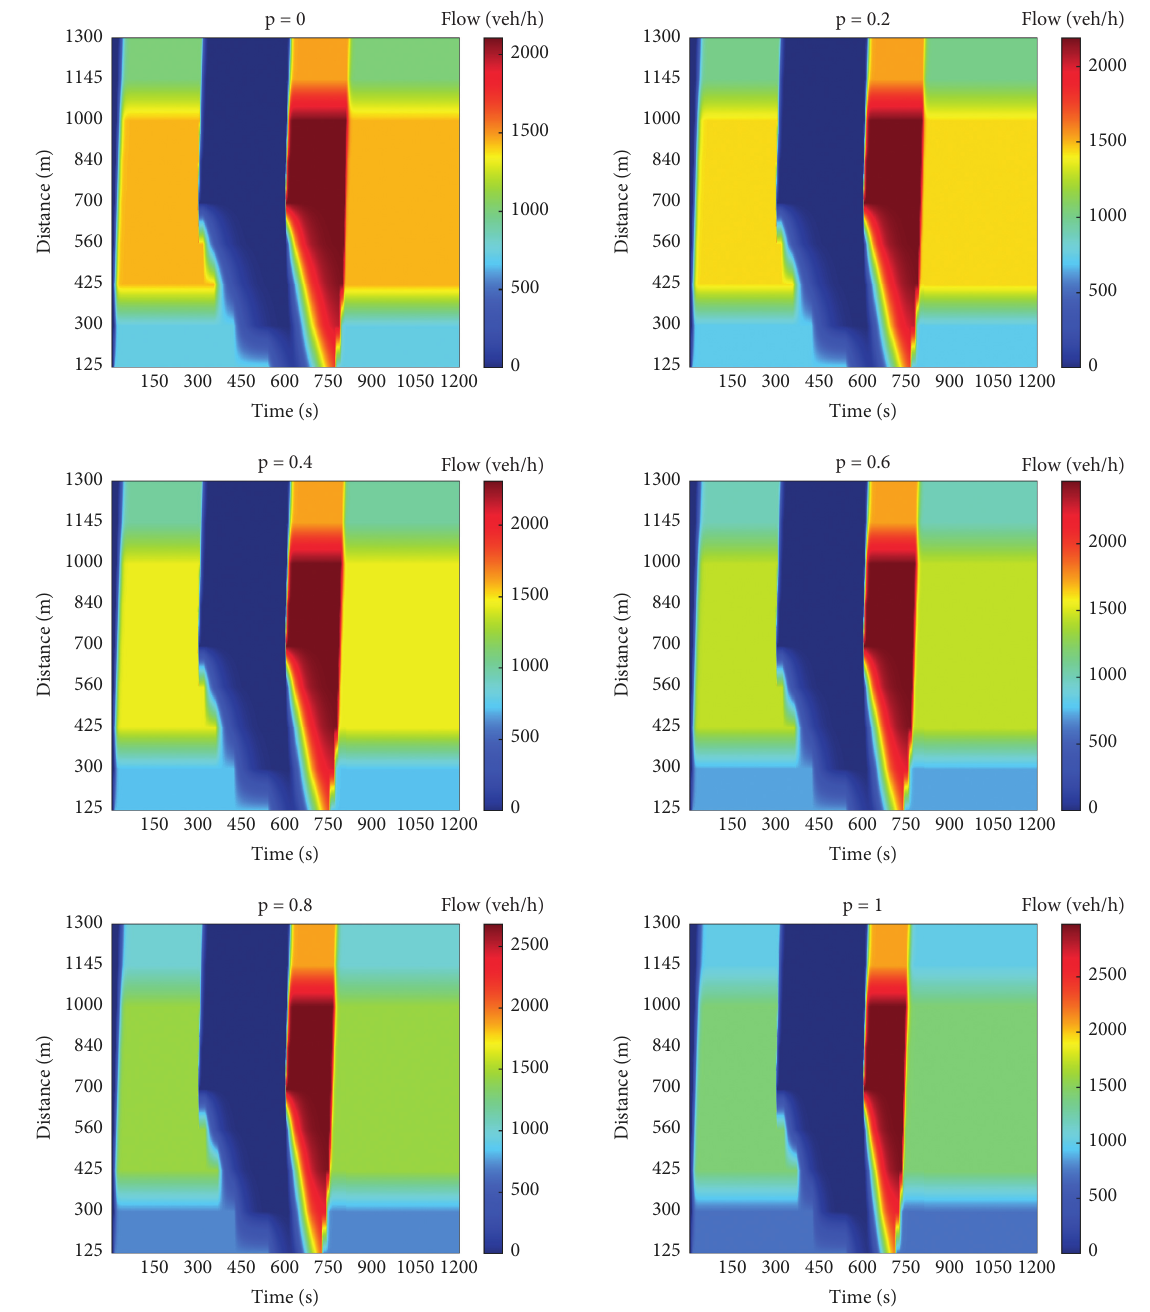
Figure 16: The variation of traffic flow based on